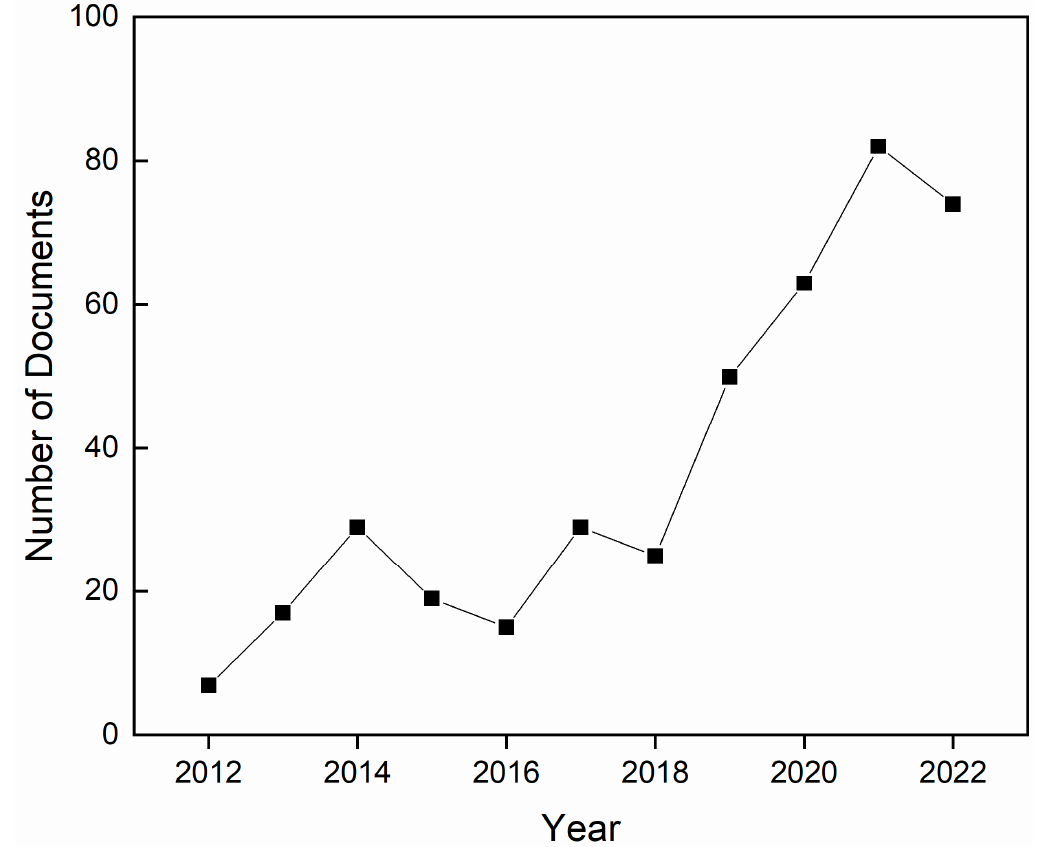
Figure 1. Number of published scientific articles, reviews, and book chapters on the topic of antimicrobial zinc oxide composite films and membranes for wound healing from 2012 to 2022. Source: Scopus.